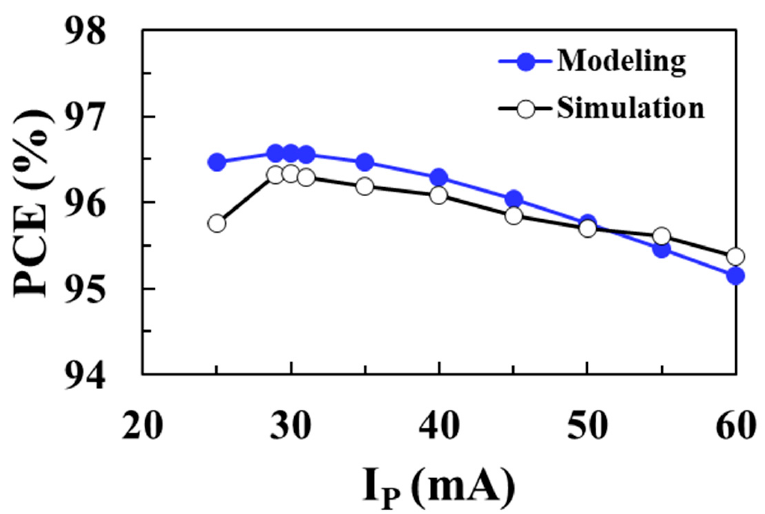
Figure 18. PCE according to the peak inductor current for an input voltage of 0.1 V and comparison with the modeling results.